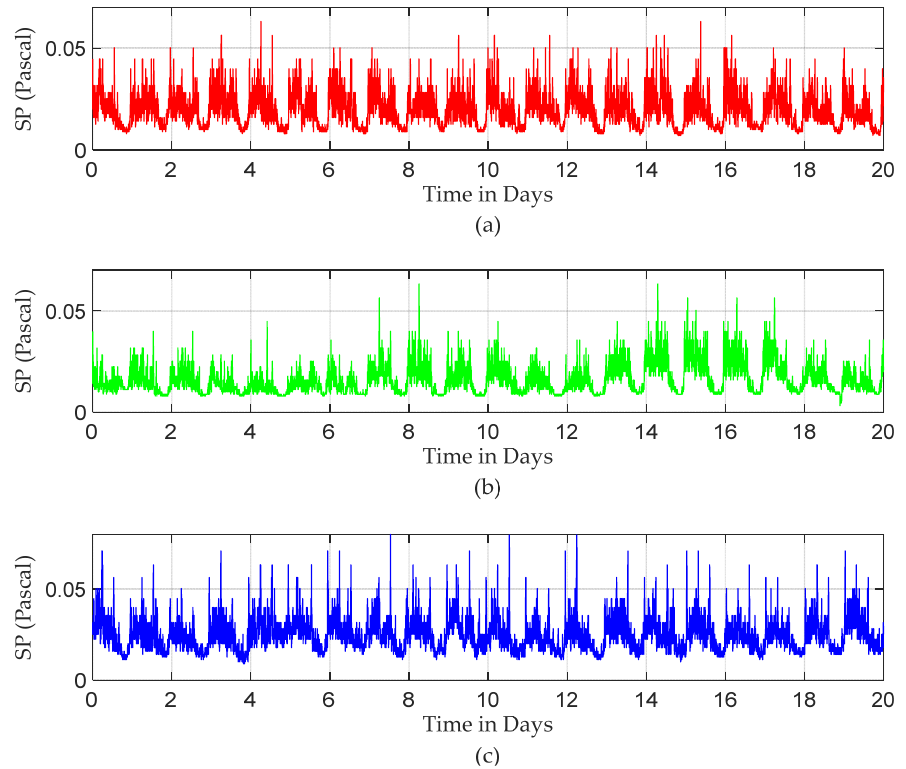
Figure 4. Actual pattens of sound levels in pascal over 20 days: ( a ) ICU1, ( b ) ICU2, and ( c ) ICU3.